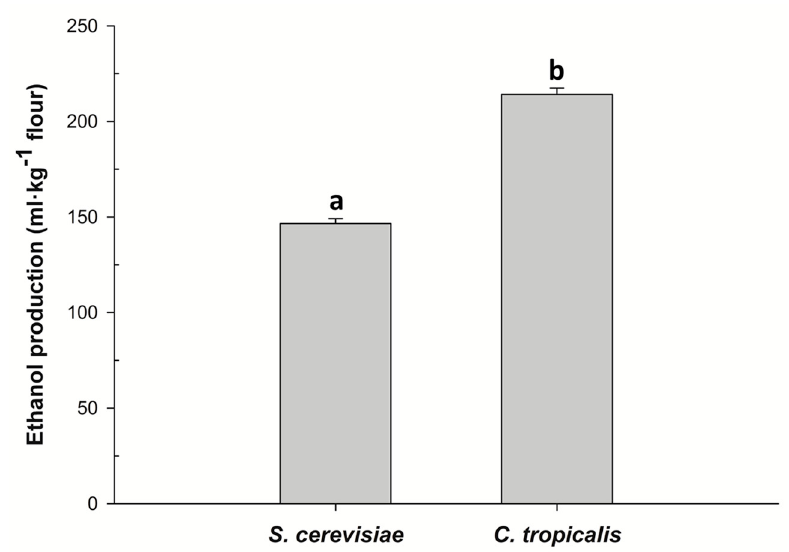
Figure 6. Comparison of ethanol yields obtained after fermentation of B. alicastrum flour with two yeast strains. The results are represented as the mean ± standard deviation of three parallel measurements ( n = 3). Different letters represent significant differences at p < 0.05.